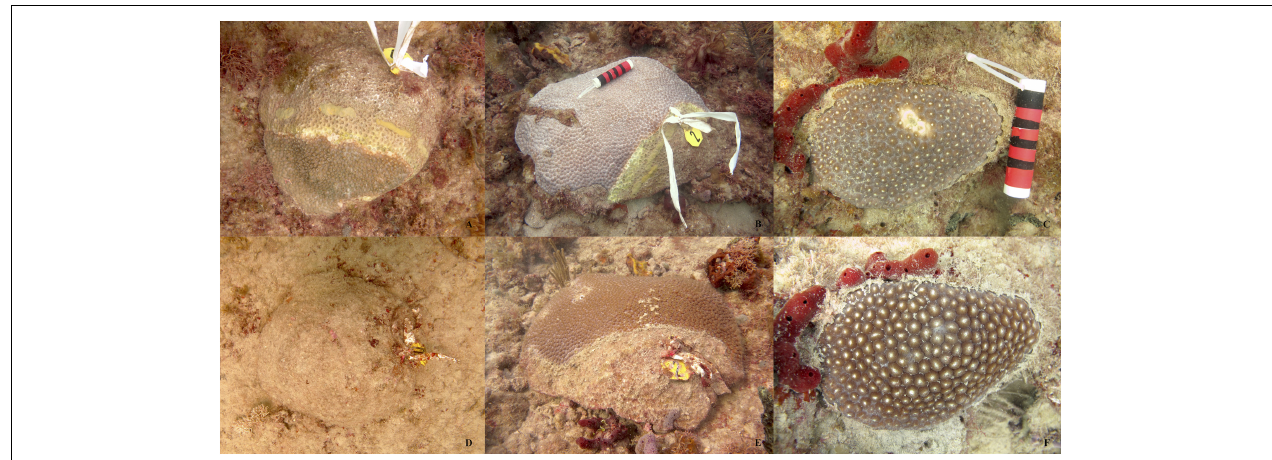
FIGURE 3 | Representative pictures showing differences in degree of mortality among diseased colonies of Montastraea cavernosa . Top pictures (A–C) are from July 2017 and bottom pictures (D–F) are the same colonies in July 2018.